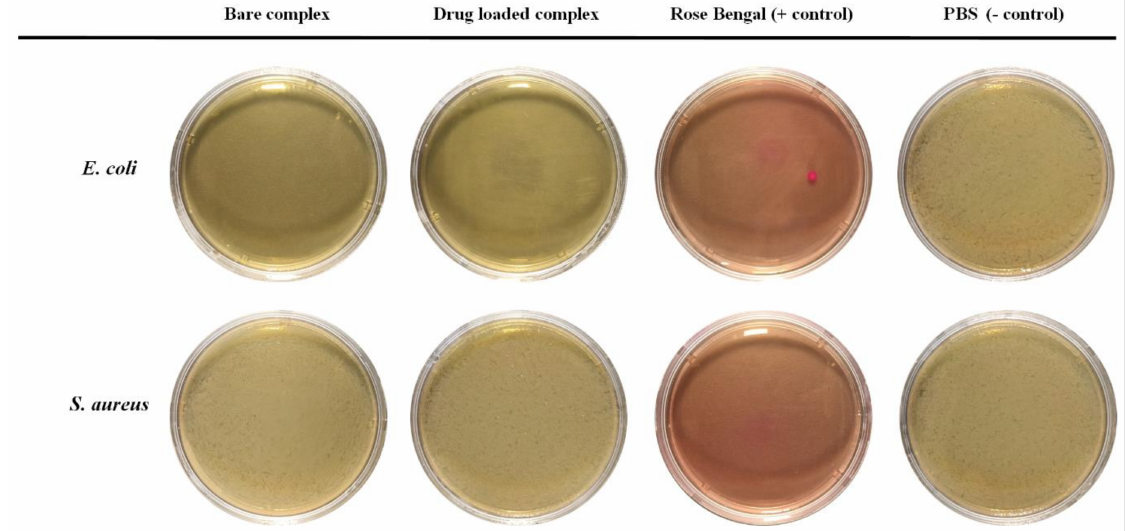
Figure 6. The results of the antibacterial test of the bare complex, drug-loaded complex, and Rose Bengal against two types of bacteria: the Gram-negative bacteria E. coli and the Gram-positive bacteria S. aureus